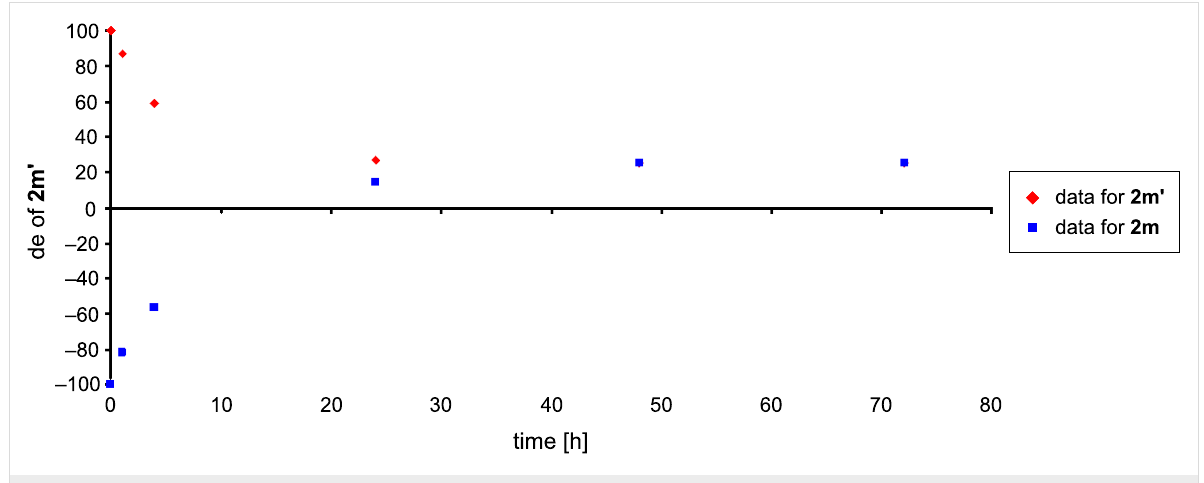
Figure 3: Thermodynamically driven epimerisation of 5-nitropiperidin-2-ones 2m and 2m’ ; identical diastereomeric excess measured for both diastereomers after 48 h and 72 h.